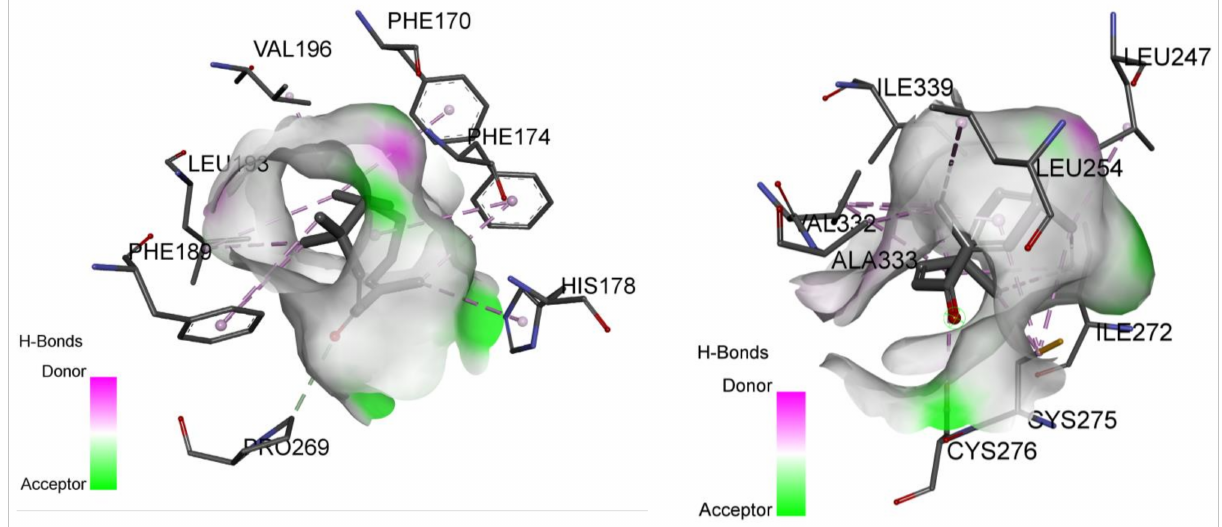
Figure 10. Predicted binding mode from the docking simulation of zerumbone with the active residues of PPAR α ( left ) and PPAR γ ( right )